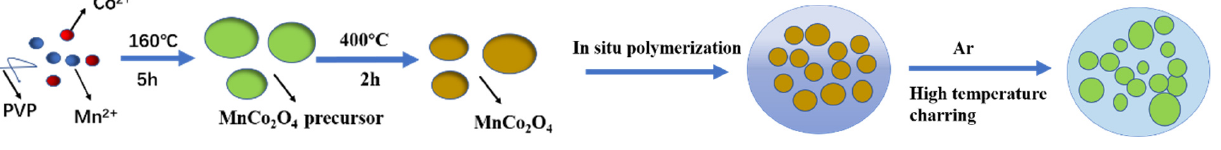
Figure 1. Schematic illustration of the composite process for core-shell MnO-Co@C nanospheres.